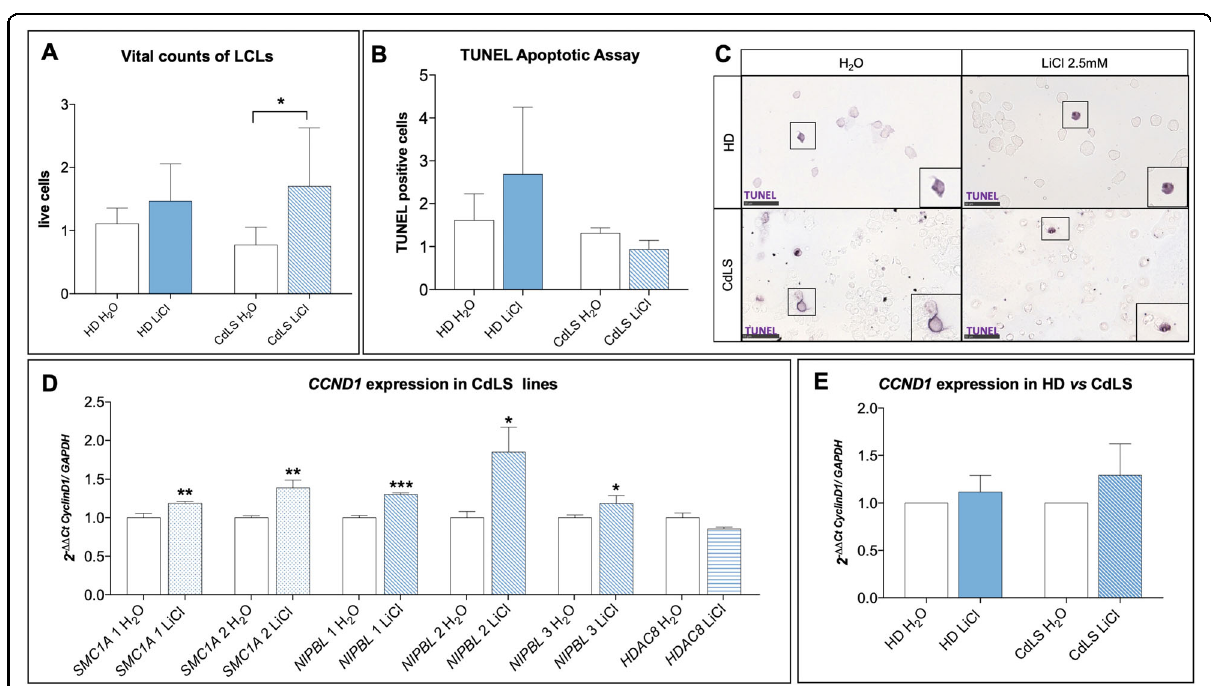
Fig. 4 Lithium rescues cell survival in CdLS LCLs through WNT activation. A Proliferation of patient-derived cells (CdLS H 2 O, white bar) is reduced compared to the proliferation rate of controls (HD H 2 O, white bar). All CdLS lines (striped bar) exposed to lithium chloride (2.5 mM) showed increased proliferation compared to untreated CdLS cells (CdLS H 2 O, white bar) and compared to treated HD cells (solid blue bar). B , C TUNEL assay was used to evaluate cytotoxicity in CdLS LCLs compared to healthy donors (HD). B Upon lithium exposure, CdLS cell lines (blue striped bar) show a decrease in cell death compared to untreated CdLS cells (CdLS H 2 O, white bar) and treated HD cells (blue solid bar). On the axis are reported: the experimental groups ( x -axis), and numbers of TUNEL positive cells at 24 h of lithium exposure, normalized on water/vehicle ( y -axis). Bars express mean ± SEM. C Examples of positive TUNEL cells. Images were taken at ×40, while insets display magni fi cation of the white square (×80). Scale bar represents 50 µm. D , E CyclinD1 gene expression was signi fi cantly increased upon lithium exposure (2.5 mM) in LCLs, especially in CdLS lines ( SMC1A : blue dotted bars, NIPBL : blue oblique bars) except for HDAC8 (blue horizontal bar). D CdLS lines are shown separately. E In pooled CdLS lines data (blue striped bar) CyclinD1 gene expression was increased upon lithium exposure (2.5mM) compared to controls (blue solid bar). Data are shown as fold change, calculated as 2 − ΔΔ Ct ± SD. p ≤ 0.05 (*), p ≤ 0.01 (**), p ≤ 0.005